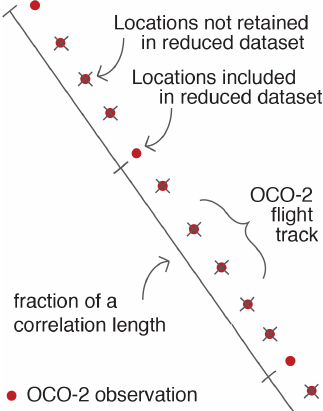
Figure 2. A schematic of the approach to data reduction proposed here. We estimate XCO 2 at one location per fraction of a correla- tion length along the satellite flight track, where the specific frac- tion must be chosen by the user. We subsequently estimate XCO 2 at each chosen location using ordinary kriging with a moving neigh-